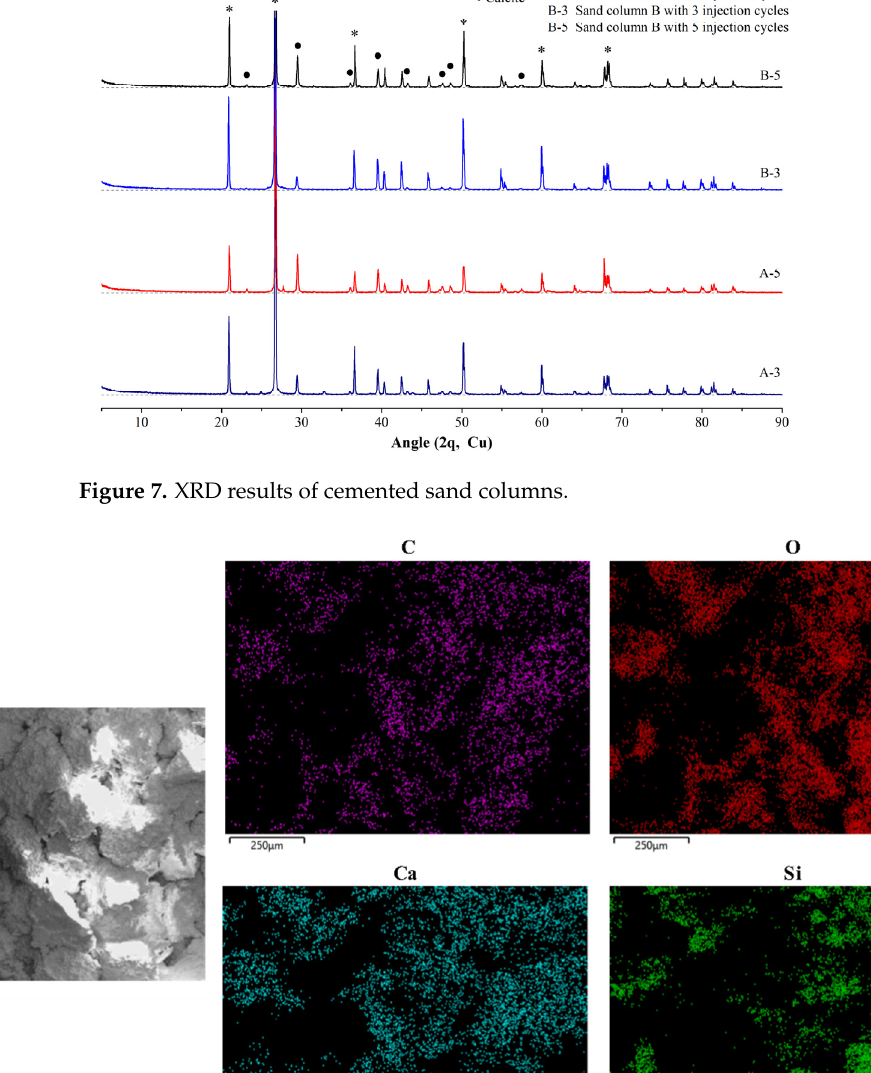
Figure 7. XRD results of cemented sand columns.